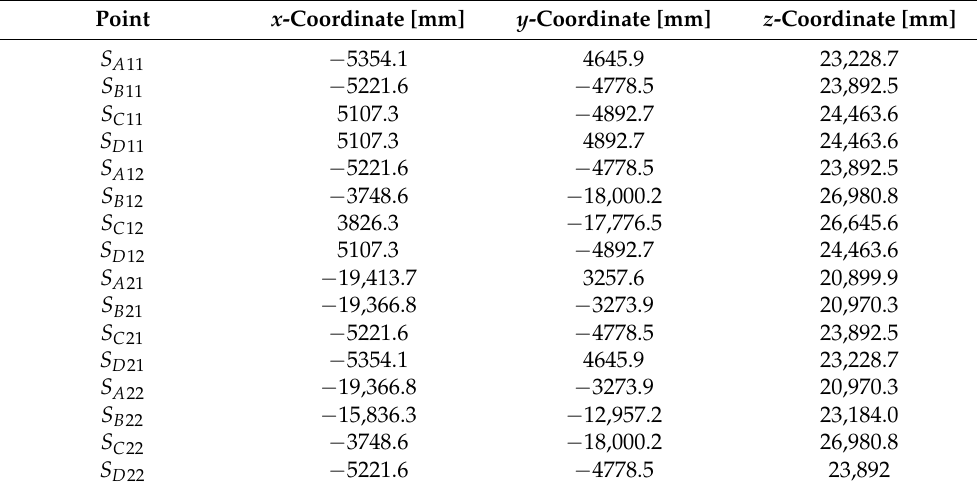
Table A3. The coordinates of the points defining the reference surface ω 1 of the first structure Σ 1 .